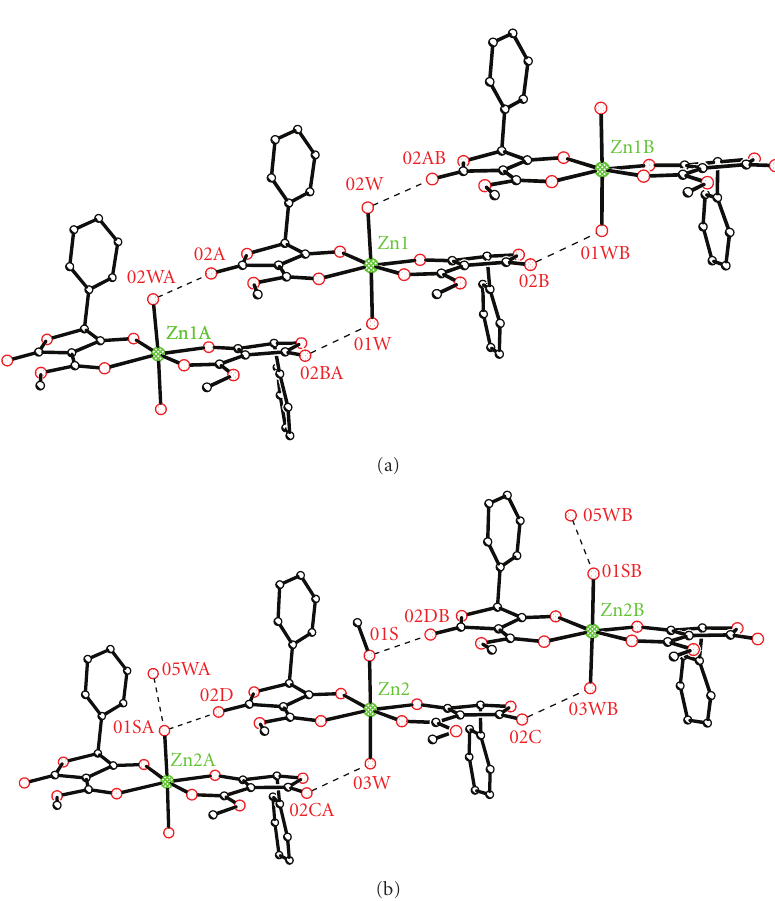
Figure 2: X-ray structure of the metal complexes showing the hydrogen bonds.